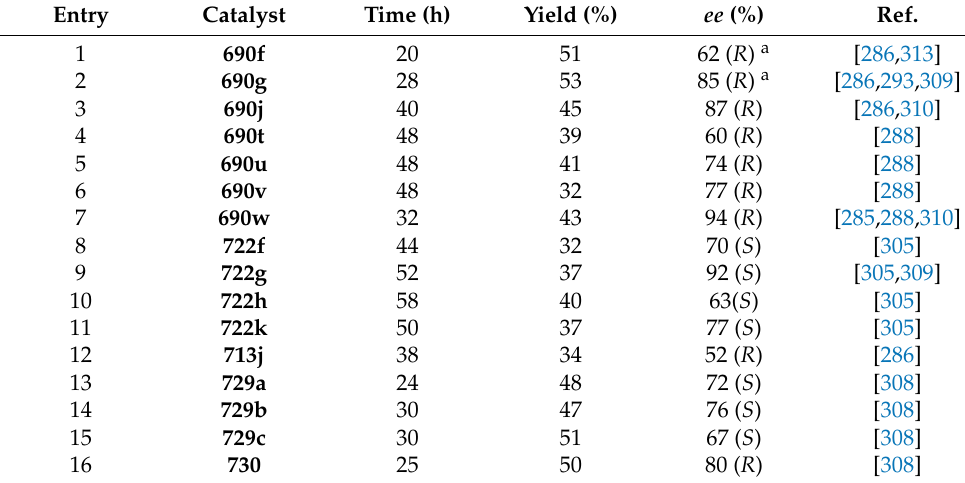
Table 5. The enantioselective Michael addition shown in Scheme